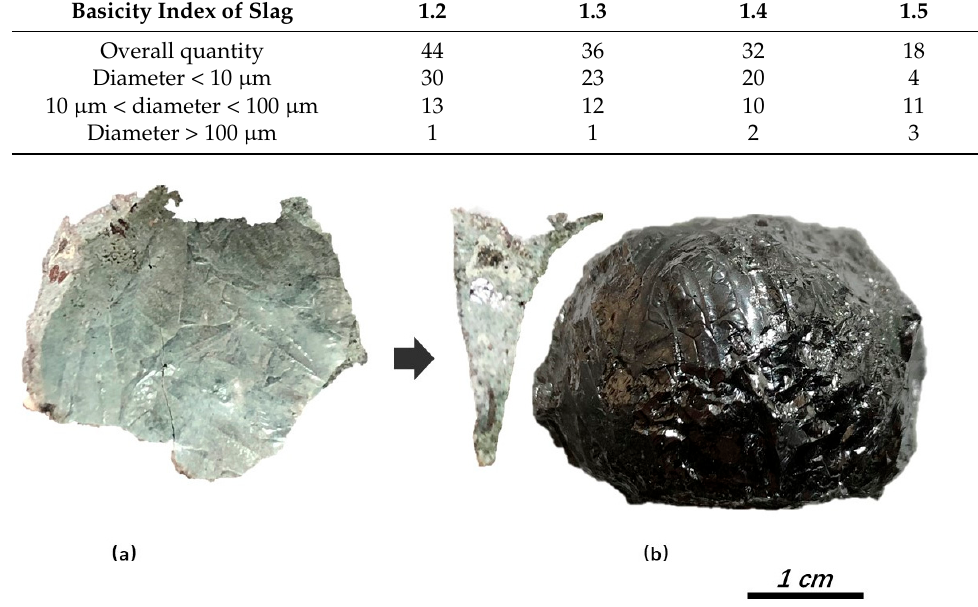
Figure 3. Solidified surface of slag that contacted with silicon ( a ) and cross-section of solidified slag and the contacted silicon lump ( b ).